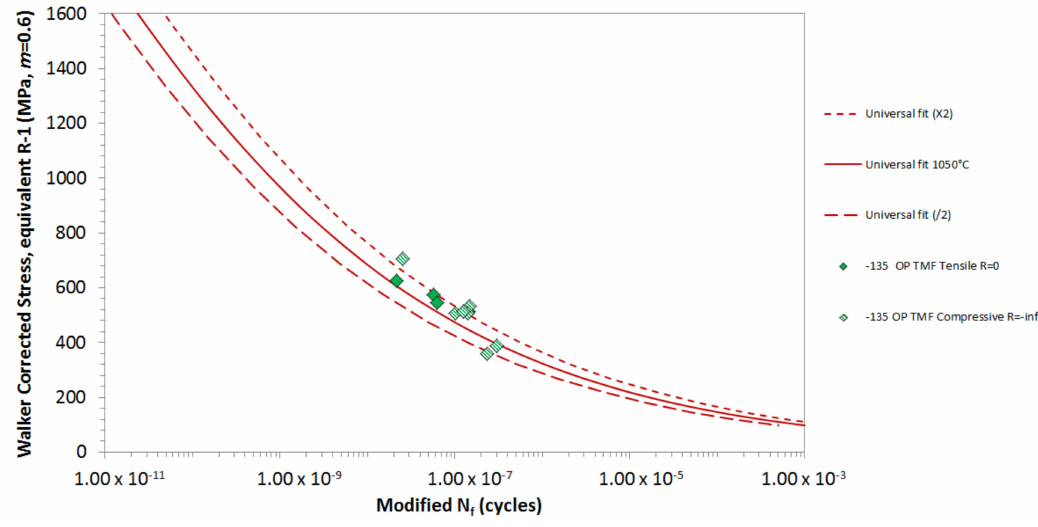
Figure 11. − 135 OP TMF, plotted using the stress at T MAX